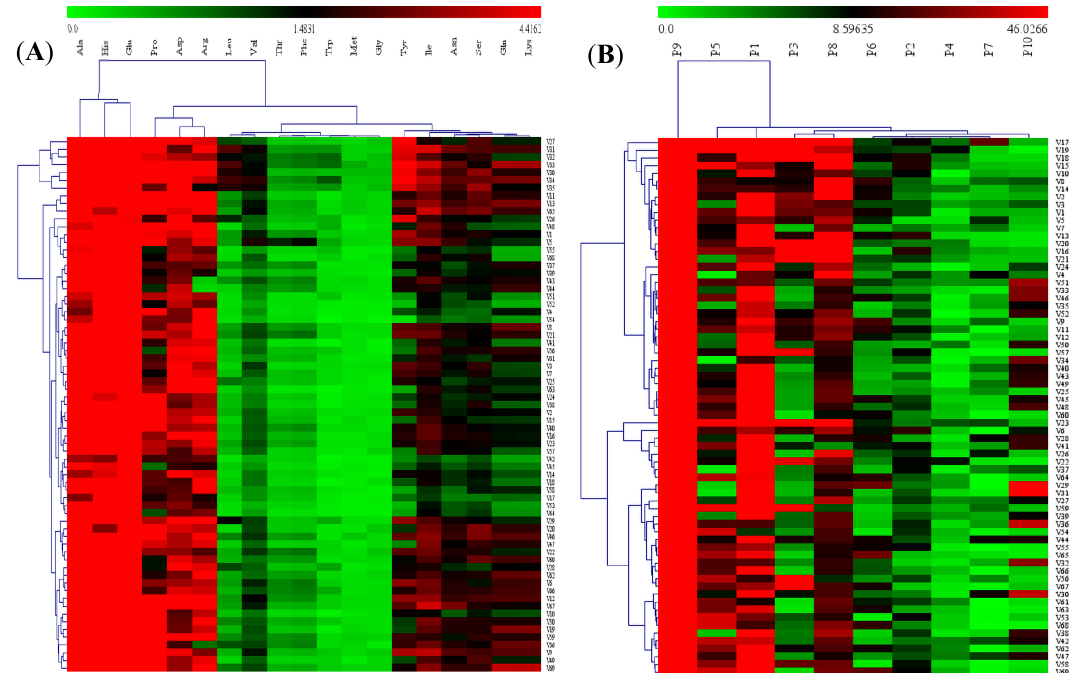
Figure 2. Hierarchical clustering and heat map visualization showing the content of free amino acids ( A ) and polyphenols ( B ) identified in cabbage samples. Green indicates low content. Dark indicates intermediate content, and red indicates high content. P1–P10 are defined in Figure 1.